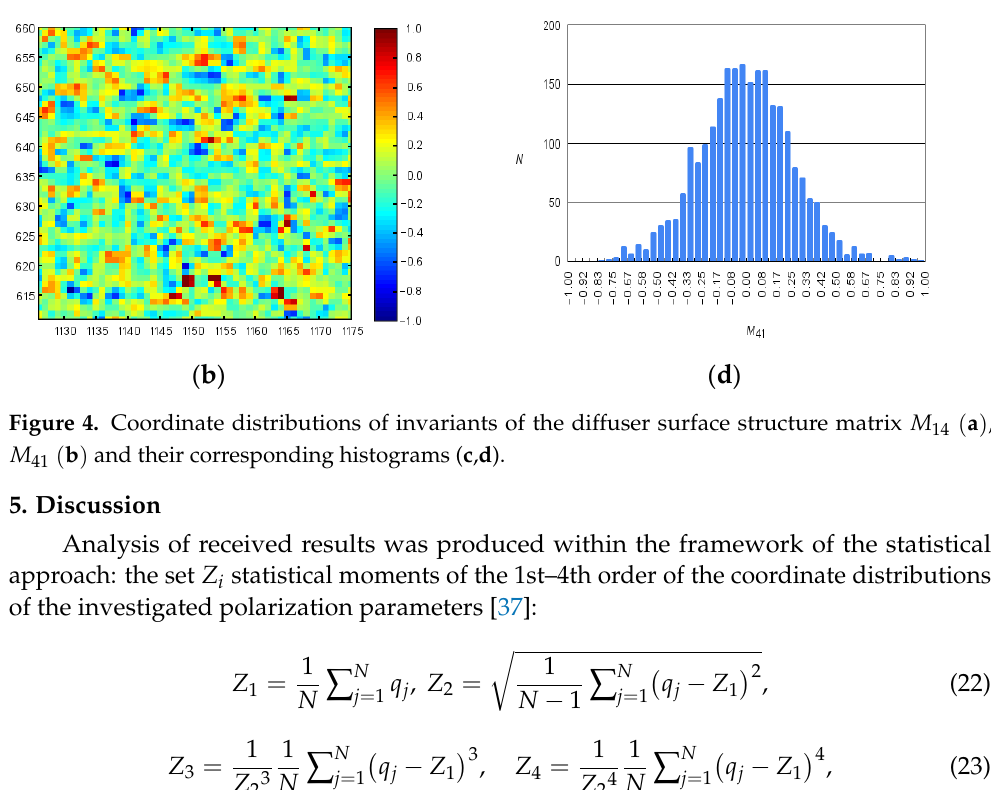
( f ) Figure 3. Coordinate distributions of the polarization degree 𝑃 ( a ), azimuth α ( b ), ellipticity β ( с ) of the radiation ellipse, and the corresponding histograms ( d – f ) of the object under research. Coordinate intensity distributions and histograms of two invariants of the diffuser surface structure matrix (𝑀 14 , 𝑀 41 ) were obtained, providing azimuthally stable infor- mation about the optically anisotropic properties of the object under investigation Figure 4.